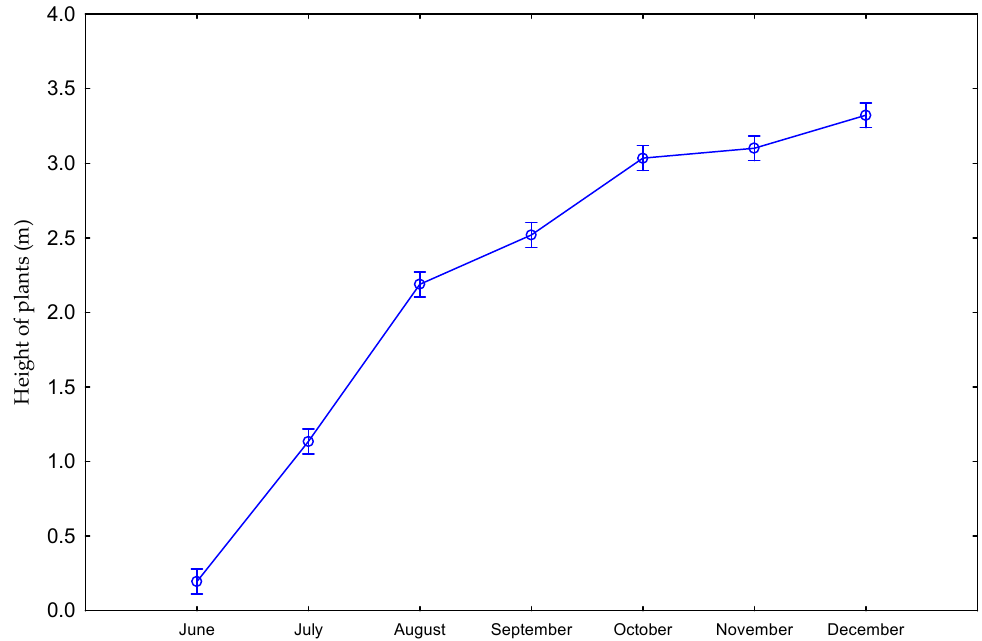
Figure 2. The height of plants during the vegetation period in the years 2014–2016 (average for years).